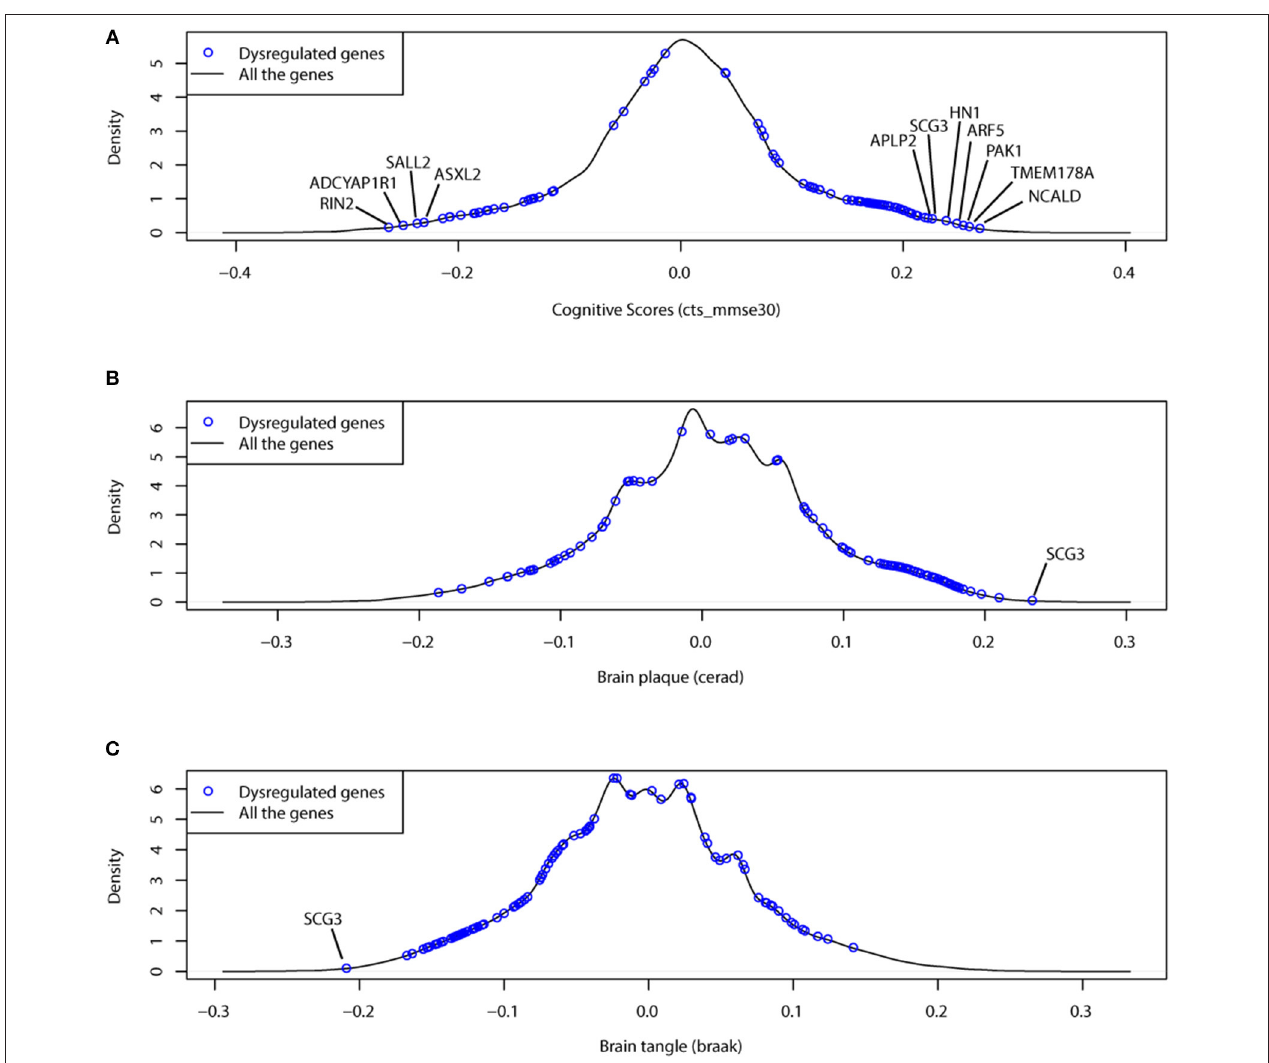
FIGURE 5 | The dysregulated genes prefer to have more association with clinical traits, including (A) cognitive test score (cts), (B) braak stage (braaksc) and (C) assessment of neuritic plaques (ceradsc). The black lines show the density plots of clinical association (correlation) for all protein coding genes; the blue points indicate the 97 dysregulated